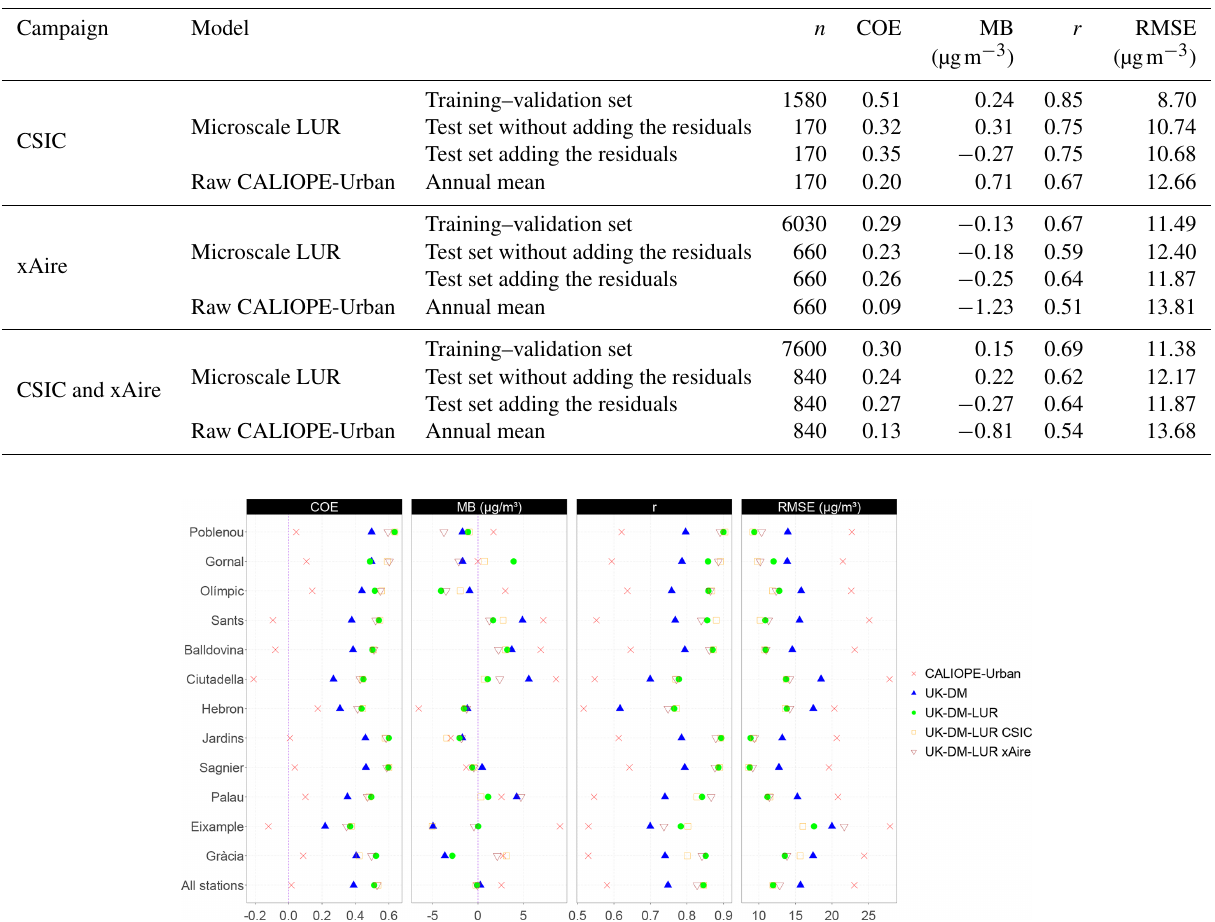
Figure A1. Statistical results for each station after applying UK-DM and UK-DM-LUR to 2019 hourly data in LOOCV. For the UK-DM- LUR application, we have considered developing the microscale LUR model with only one experimental campaign (UK-DM-LUR CSIC or UK-DM-LUR xAire) or both of them (UK-DM-LUR). In addition, we show the statistical results for the CALIOPE-Urban estimates at each station. All stations refer to the average over all